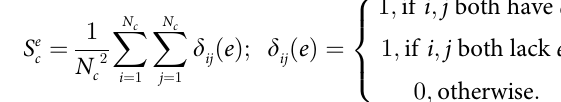
S1 Fig. Agent-based modeling of T6SS firing and response. (A) Diagram of 2D competition simulation showing initial ( t ; 100 cells) and final ( t ; approximately 10,000 cells) cell con- start end figurations. (B) Each simulation timestep, every T6SS+ cell fires N times with N firings , i , i firings , i drawn independently from a Poisson distribution with mean k . (C) Cell’s growth costs are fire computed from values of N ; costs are assumed to scale linearly with a cell’s firing rate. firings , i (D) Cells respond to successful translocations with a steplike dose–response curve: once a cell’s cumulative translocation count reaches threshold N , that cell dies and becomes a “Vic- hits tim”; see (E). Cells of the same genotype are immune to each other’s effectors. (E) Cartoon of cell-based processes summarizing cell-based T6SS firing and response parameters; here, k grow is the maximum specific growth rate, and k the lysis rate post-T6SS intoxication. ( F ) Initial lys parameter sweep showing final attacker frequencies as a function of T6SS firing rate, for vari- ous weapon cost parameters c (legend). Circles and bars denote means and standard devia- tions; 5 simulation replicates per case. Raw data are available at